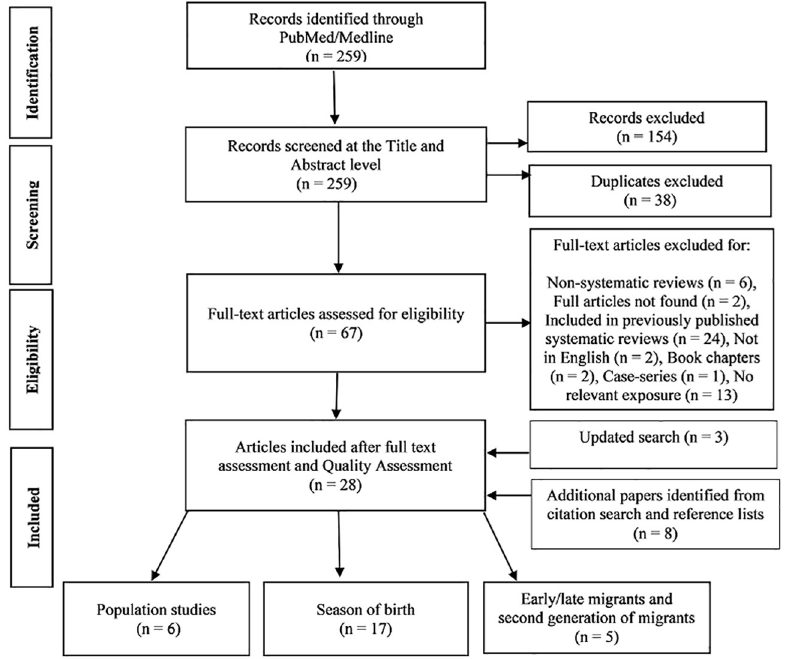
Fig 1. Flow chart with information on the identified and excluded